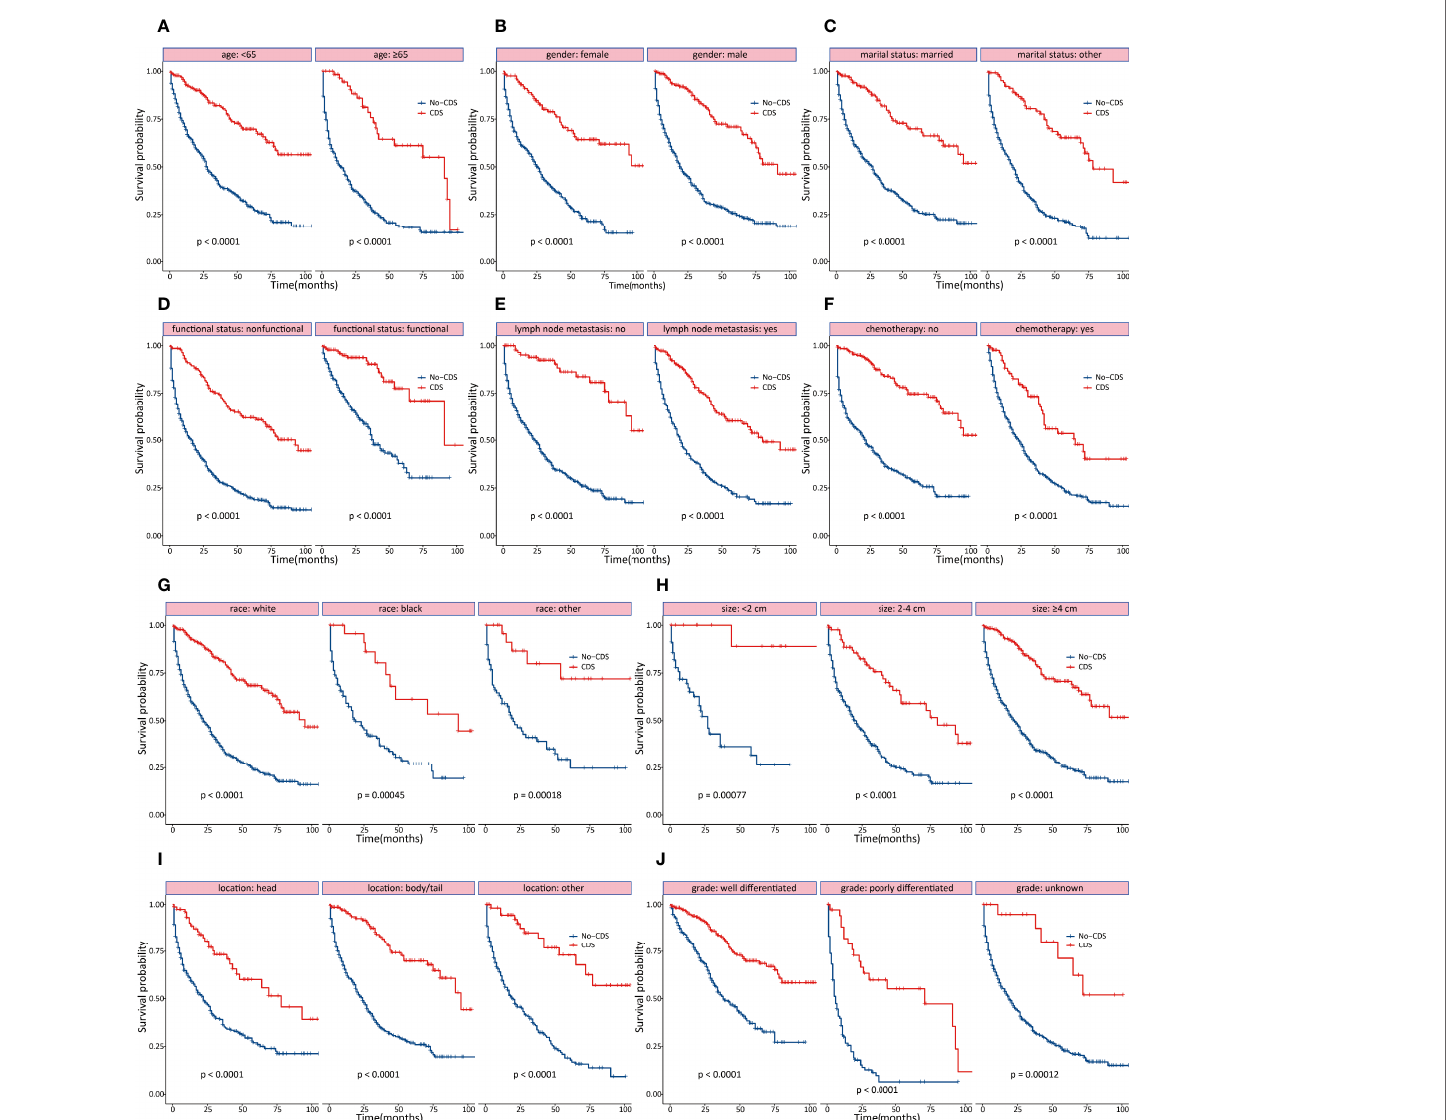
FIGURE 2 | Subgroup analyses of OS strati fi ed by clinicopathological characteristics. (A) age (B) gender (C) marital status (D) functional status (E) lymph node status (F) chemotherapy (G) race (H) tumor size (I) tumor location (J) tumor